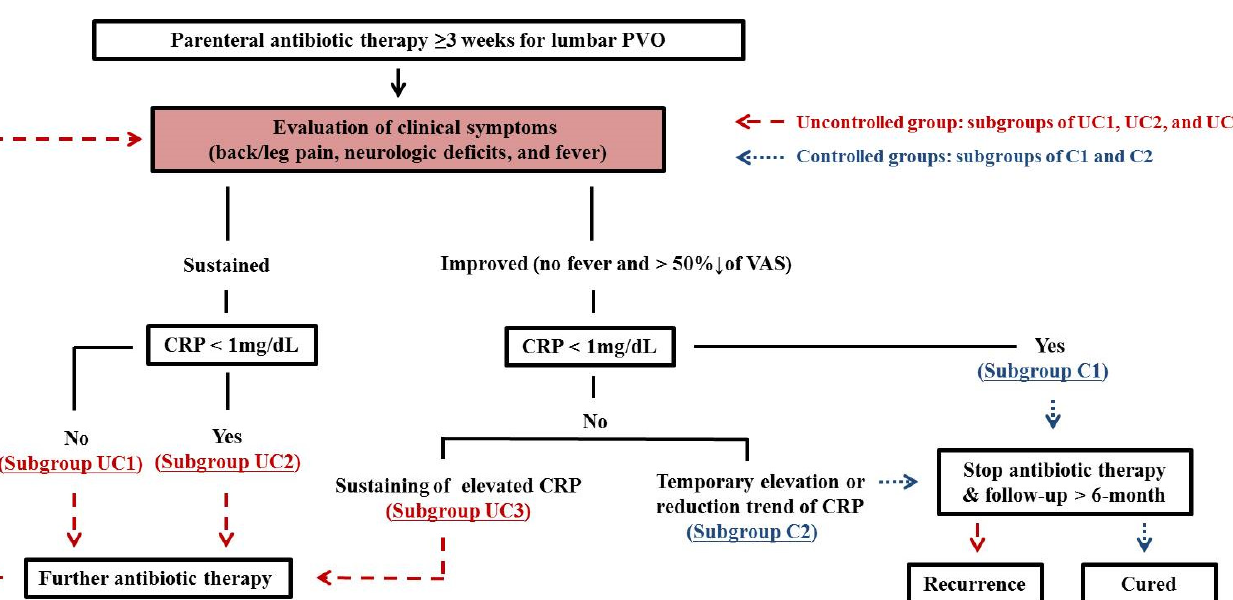
Figure 1. The algorithm of clinical assessment of therapeutic response (PVO-flowchart). Finally, 53 patients underwent 80 rounds of clinical assessment of therapeutic response based on a PVO flowchart during antibiotic therapy. The decisions of therapeutic response consisted of 36 Uncontrolled and 44 Controlled. Simultaneous 18 F-FDG-PET/MRIs were performed at each clinical assessment (1.51 times/patient). PVO, pyogenic vertebral osteomyelitis; CRP, C-reactive protein; VAS, visual analog scale; 18 F-FDG-PET/MRI, 18 F-fluorodeoxyglucose positron emission tomography/magnetic resonance imaging.